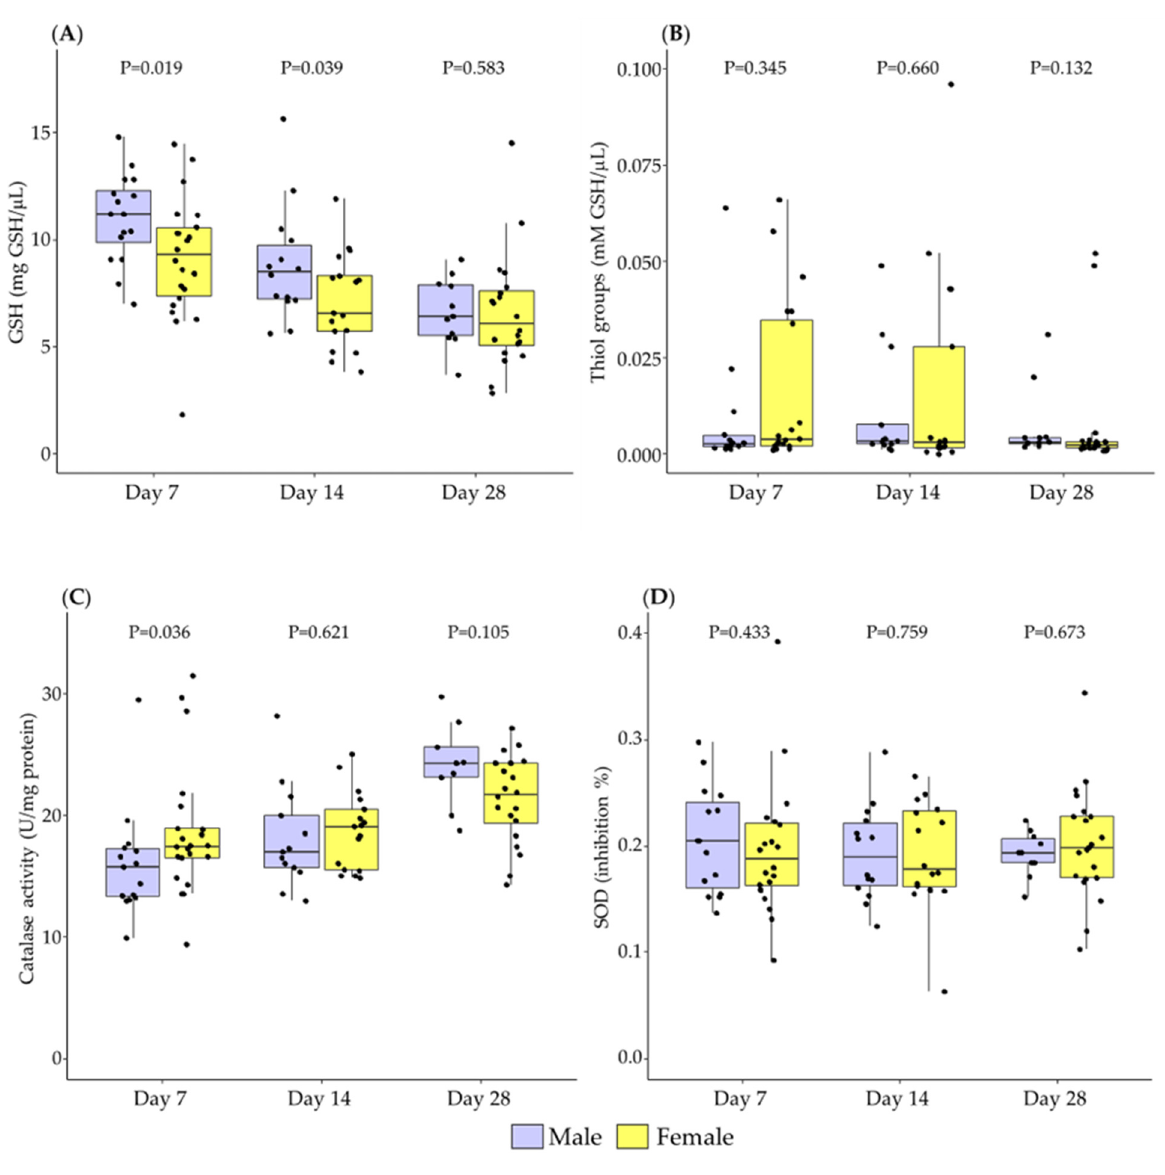
Figure 3. The evolution of breast milk total GSH levels ( A ), thiol groups ( B ), catalase activity ( C ), and SOD activity ( D ) during the first month of lactation according to the sex of the newborn. Data show median and interquartile range [Q1; Q3]. Neonatal sex was compared according to the day of lactation using the Mann-Whitney U test and extracted p -Value ( p ) adjusted by Holm-Bonferroni multiple comparison methods was reported in the figure. GSH: reduced glutathione; SOD: Superoxide Dismutase.